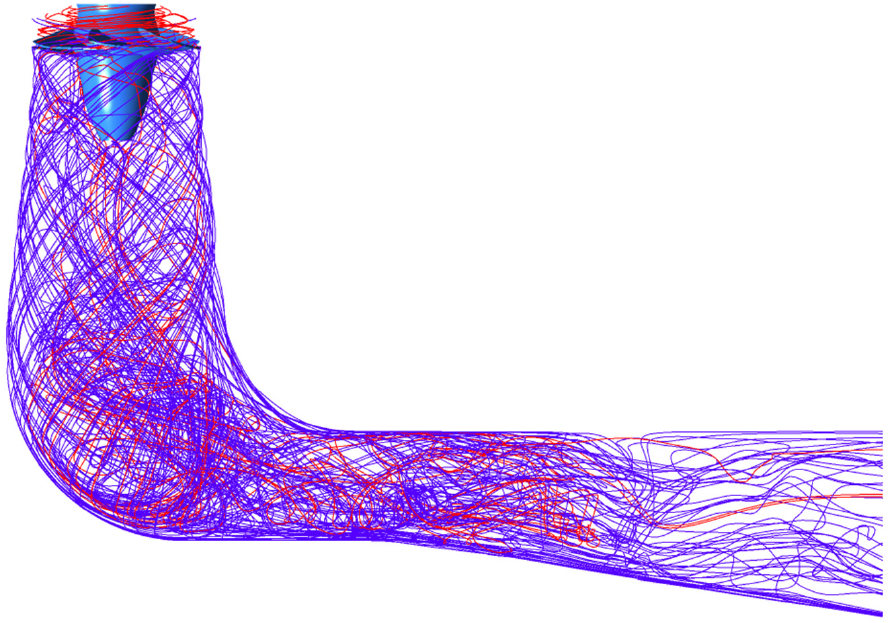
Figure 20. Streamlines coming from (blue) and to (red) the runner